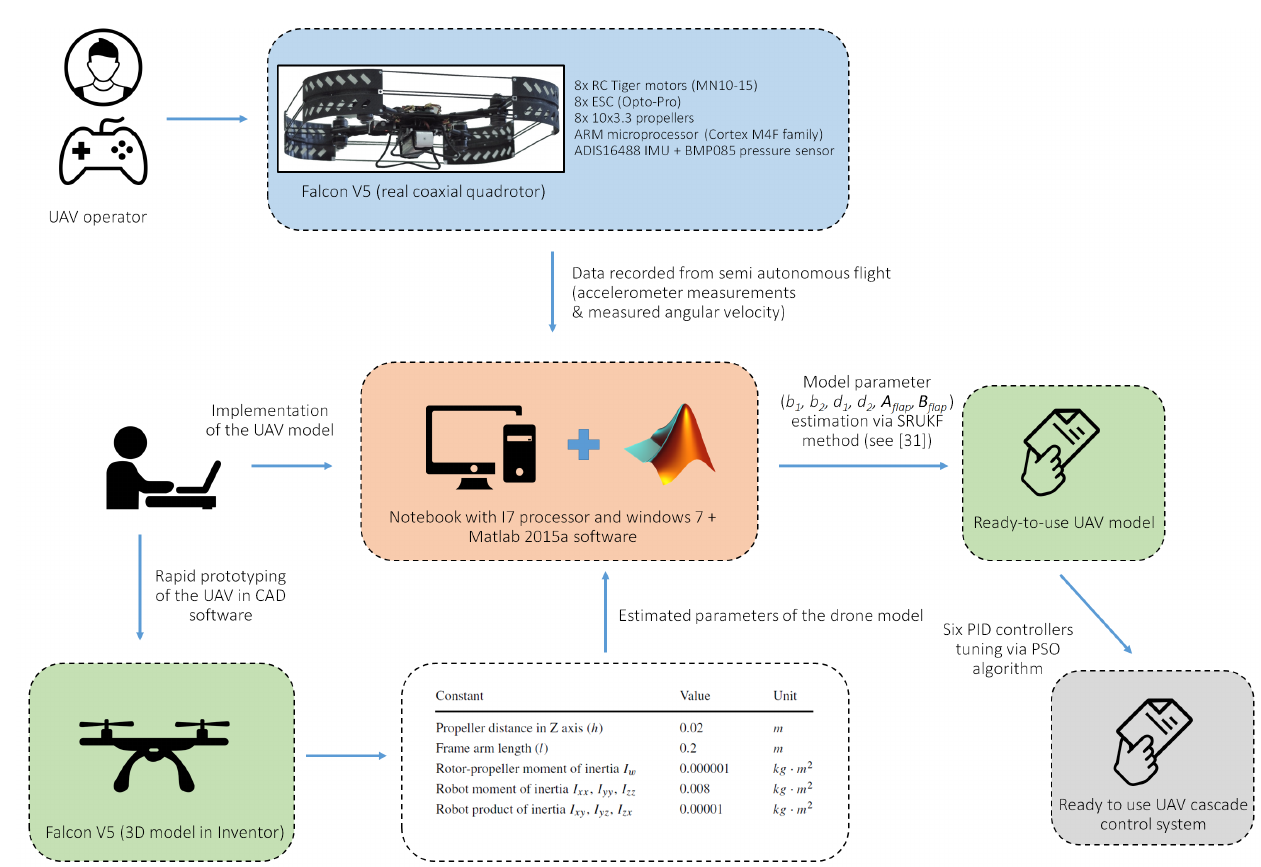
Figure 7. Block diagram illustrating the following steps to obtain the unmanned aerial vehicle (UAV) model in control